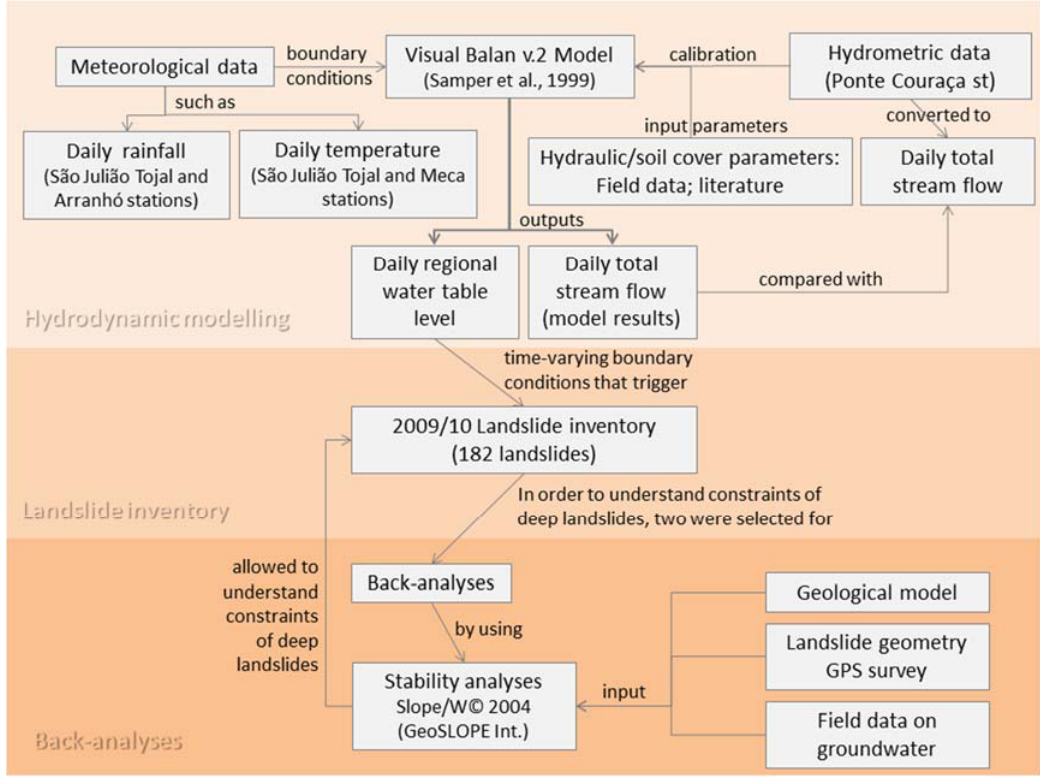
Figure 3. Flowchart with methods used in the present study.